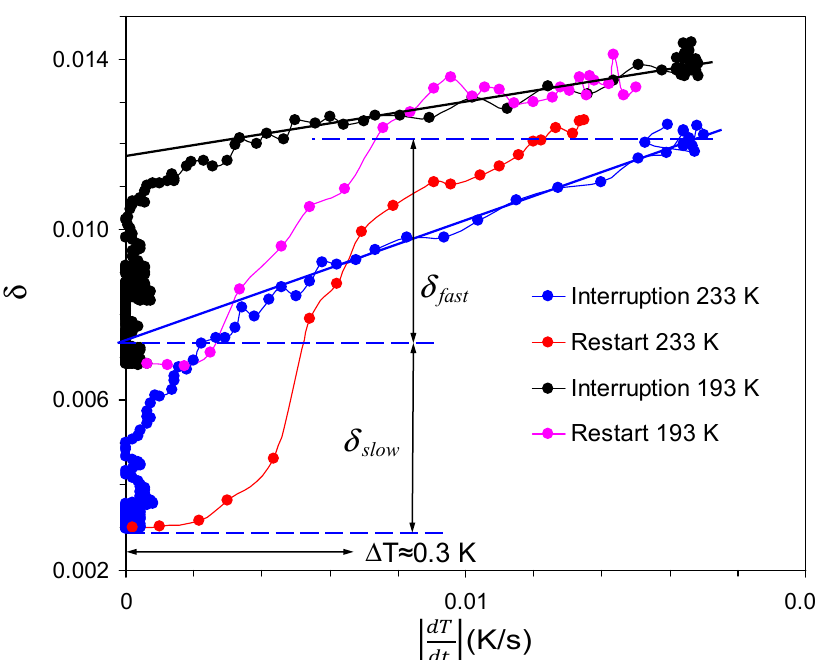
Figure 8. Internal friction versus absolute value of T-dot during interruption of cooling at 233 and 193 K of Structure 1 sample with two a/c twin boundaries. Vertical arrows mark the “fast” and “slow” internal friction components δ fast and δ slow in the data taken at 233